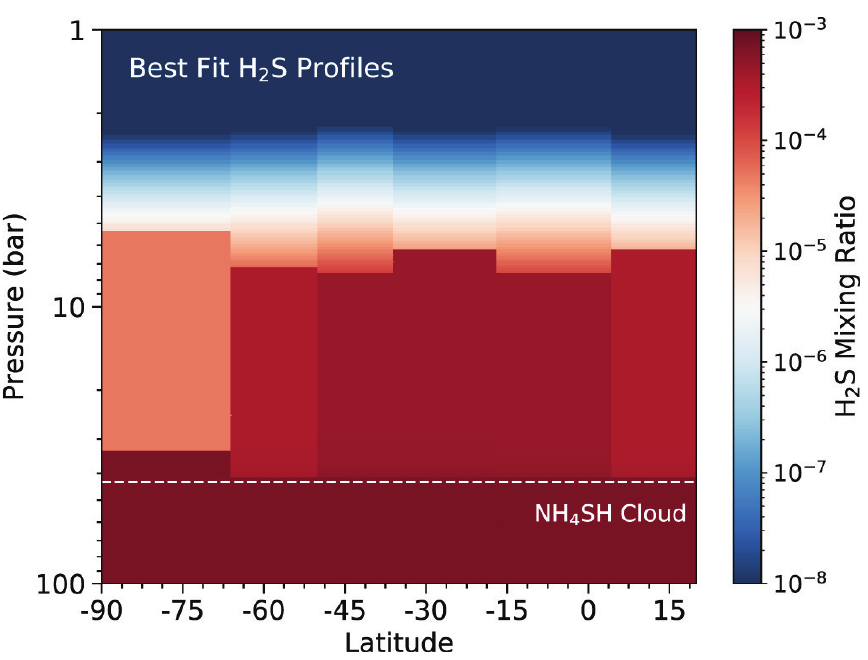
Figure 20. The latitudinal distribution of the H 2 S profiles that best match the radio brightness temperatures as measured for Neptune